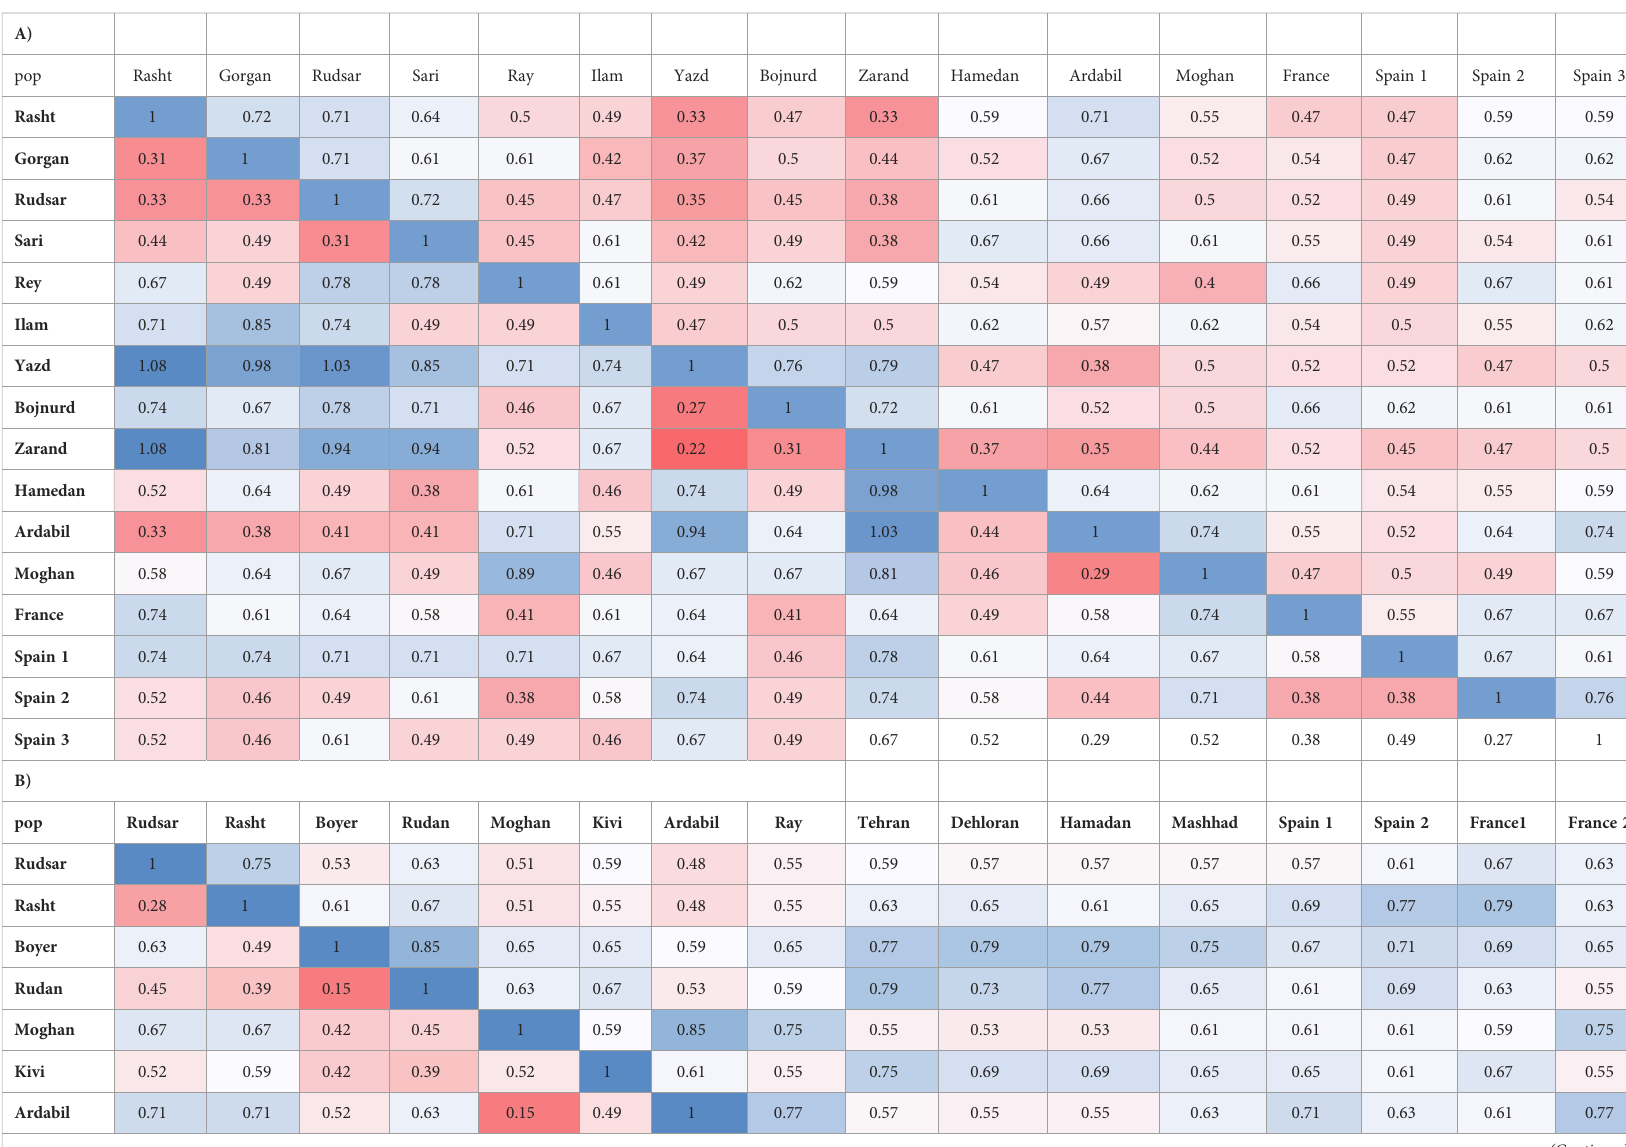
TABLE 5 Nei ’ s unbiased measures of genetic identity (above diagonal) and genetic distance (below diagonal) primers in A. retro fl exus (A) and C.album (B) . A) pop Rasht